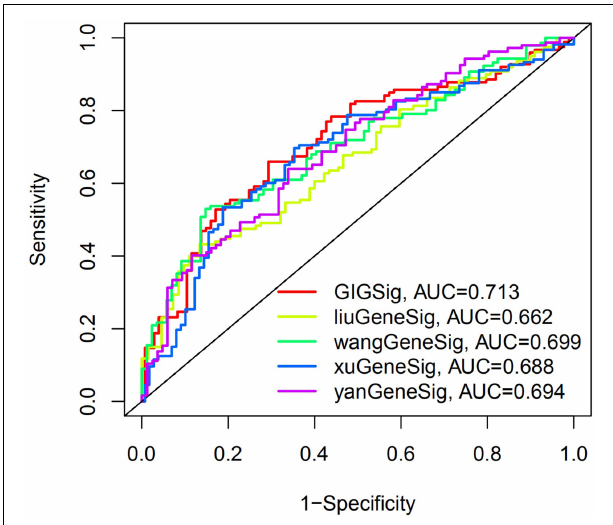
FIGURE 4 | The AUC at 3 years of OS for the GIGSig and the four previously reported gene-based signatures.